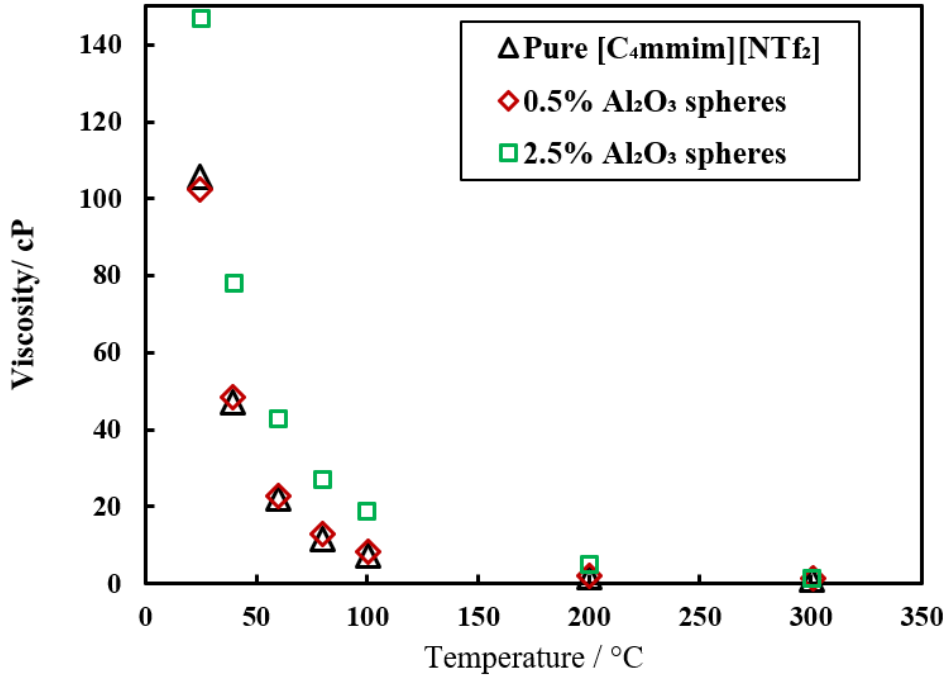
Figure 16. Effect of the spherical Al 2 O 3 nanoparticle on [C 4 mmim][NTf 2 ] IL viscosity as a function of temperature [60]. Reproduced with permission from [Foxr], [Energy Fuels]; published by [ACS], 2013.